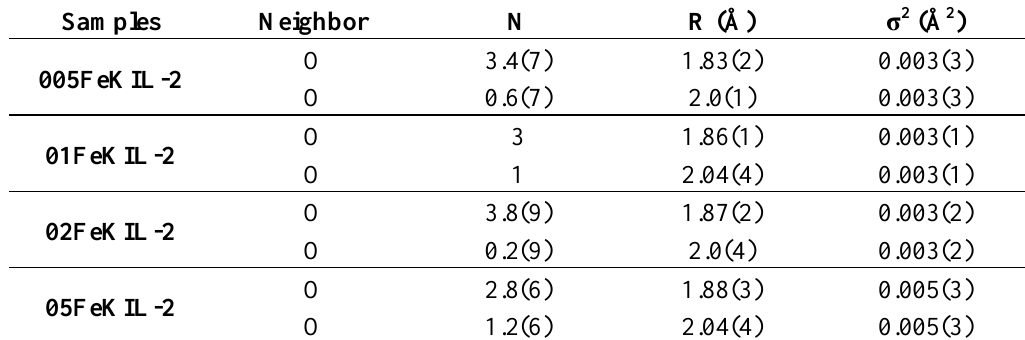
Table 3. Structural parameters of the nearest coordination shells around Fe atom in the FeKIL-2 samples: type of neighbor atom, average number N, distance R, and Debye-Waller factor σ 2 . Uncertainties in the last digit are given in